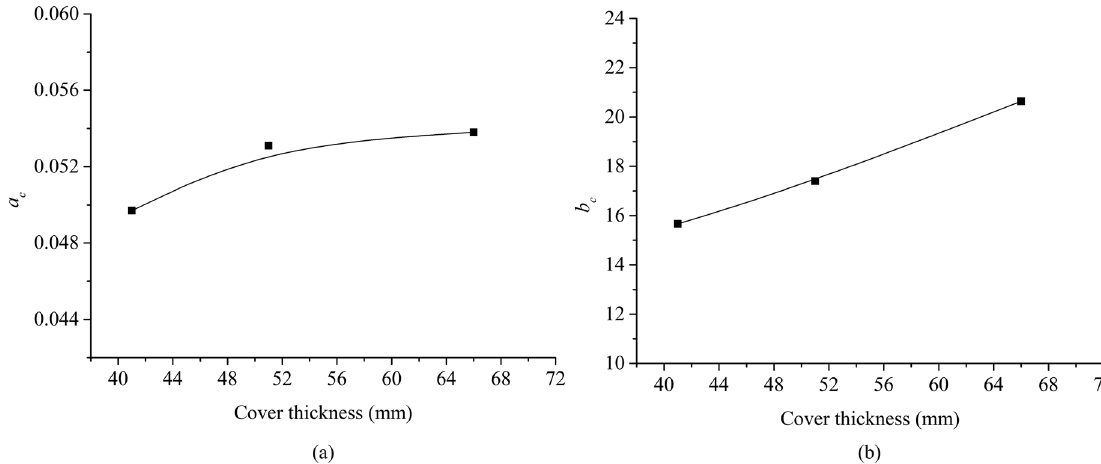
Figure 6: Parameters a c and b c of specimens with di ff erent cover thicknesses. ( a ) Parameter a c ; ( b ) Parameter b c